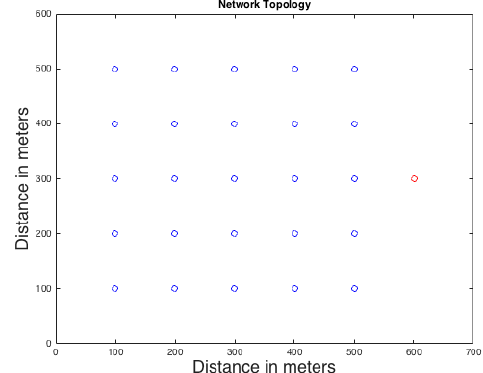
Figure 2. Network topology: blue nodes are regular sensors and the red node is the sink.